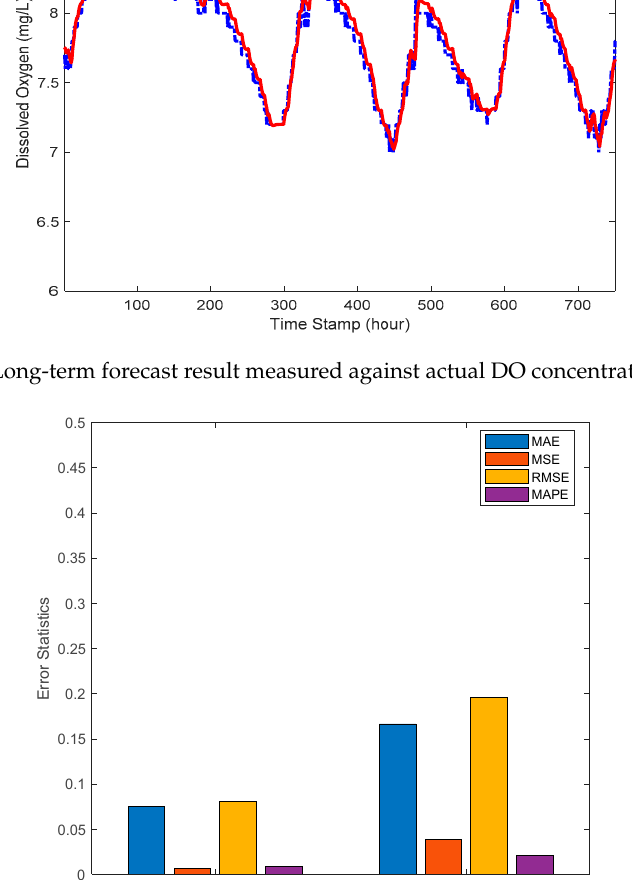
Figure 8. Long-term forecast result measured against actual DO concentration values.